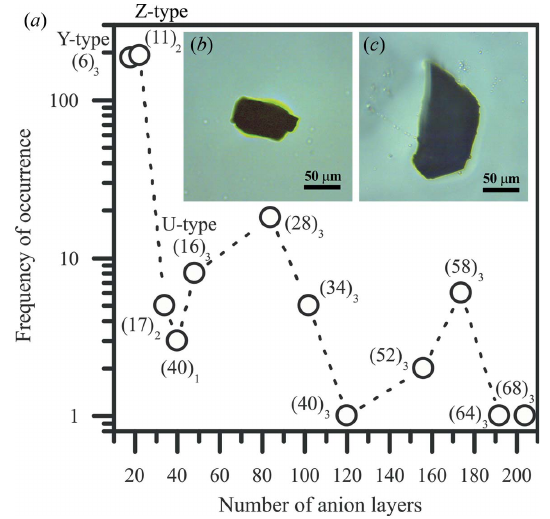
Figure 3 ( a ) Quantity of crystals found as a function of the number of anion layers plotted on a logarithmic scale. The inset shows pictures of mixed-layer hexaferrite crystals belonging to the ( b ) M 2 Y 4 and ( c ) M 4 Y 8